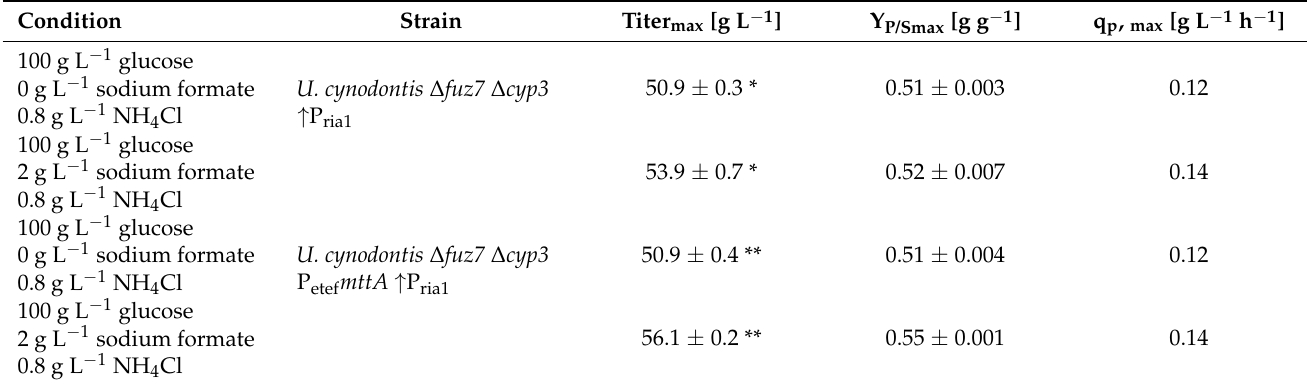
Table 3. Itaconate production parameters during shake flask cultivations of metabolically engineered U. cynodontis strains. Cultivations were carried out in shake flasks as described in Section 2.1. MTM